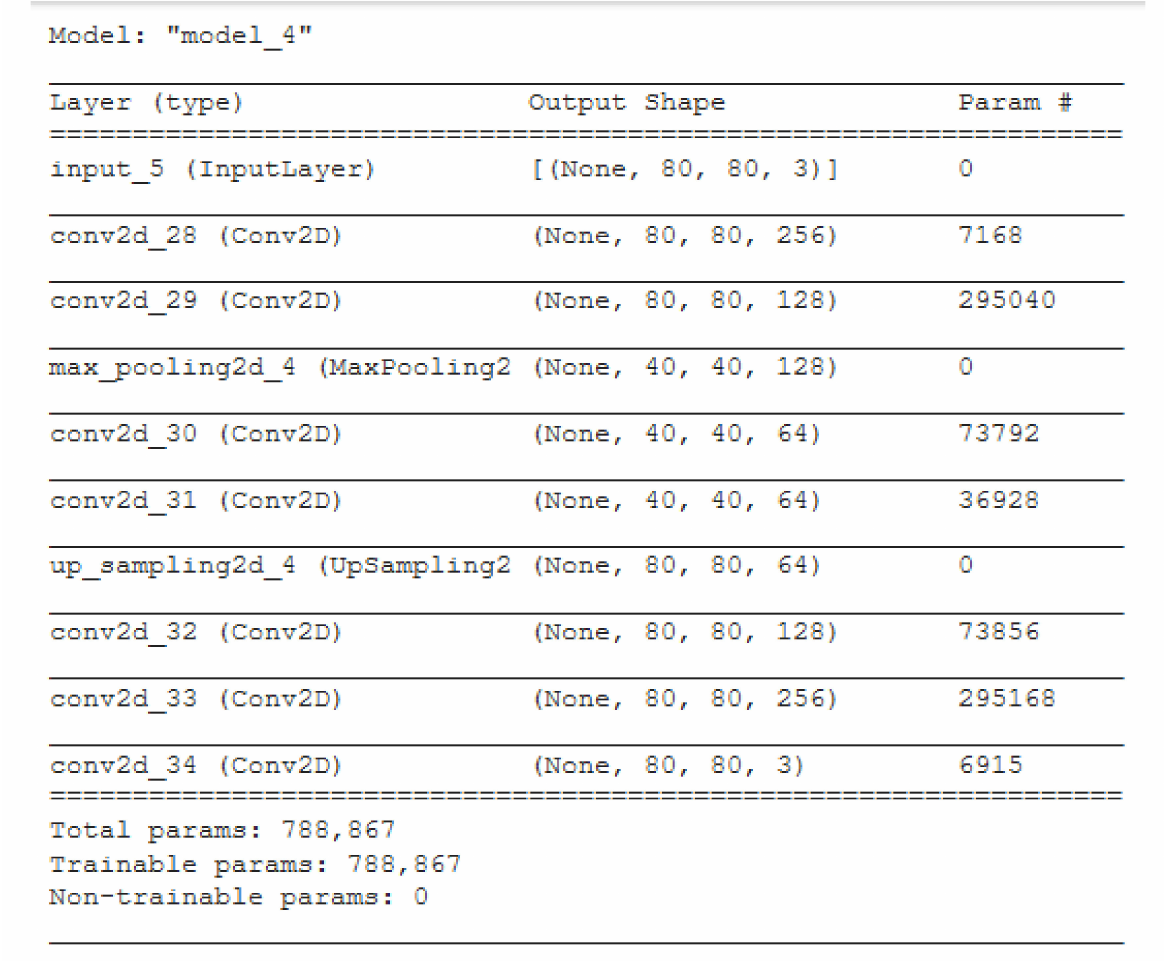
Figure 12. Model Summary of Convolutional